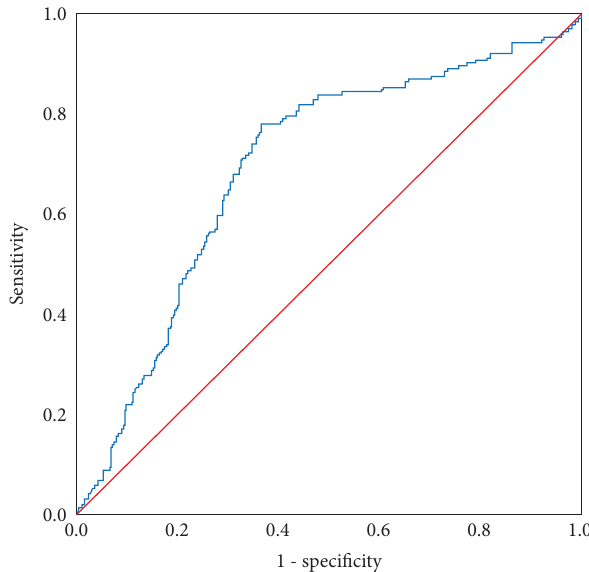
Figure 2: ROC curve for the TyG index as a predictor of LAA